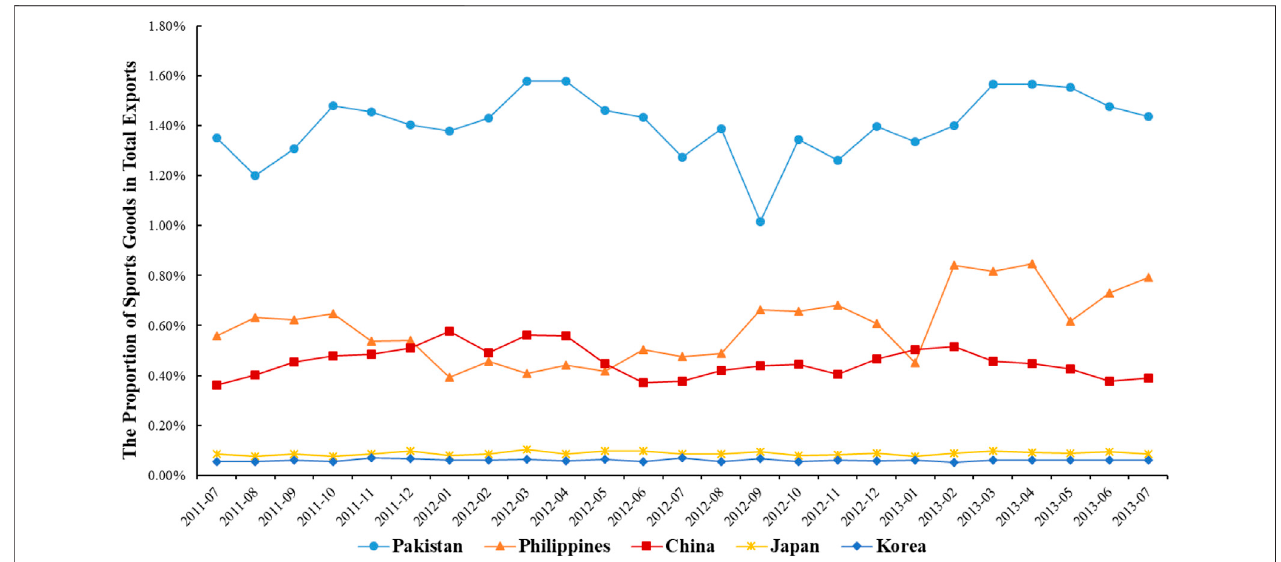
FIGURE 1 | The Exports of Sports Goods in Asian